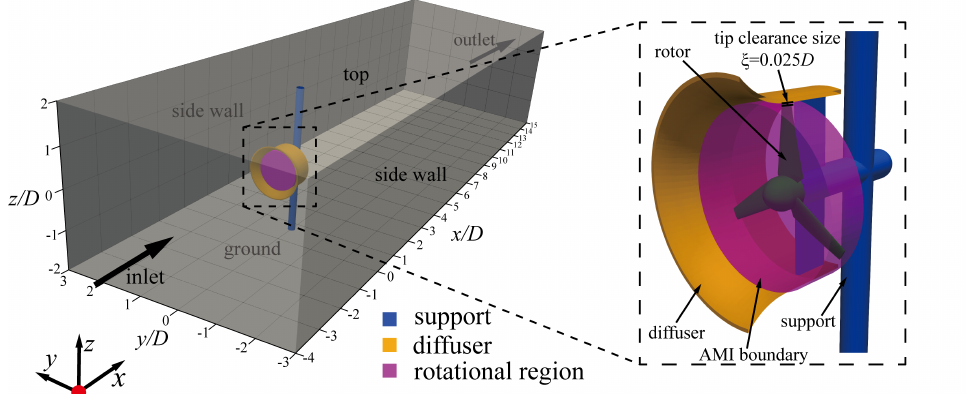
Figure 2. Schematic of computational domain and boundary conditions.